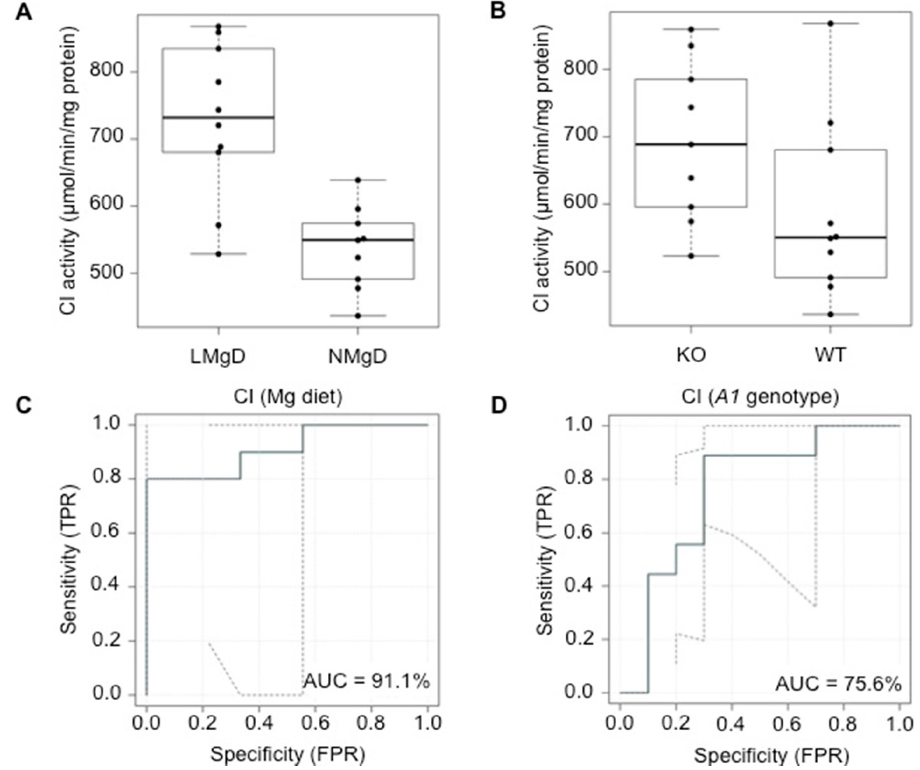
Figure 4. Impact of dietary Mg content and Slc41a1 genotype on the activity of complex I (CI) in murine cardiac mitochondria. ( A ) Box-and-whisker plot overlaid with dot plot showing the influence of dietary Mg content (LMgD vs. NMgD) and ( B ) Slc41a1 genotype ( Slc41a1 − / − vs. Slc41a1 +/+ ) on CI activities in murine mitochondria. For both, A and B, the original source data and corresponding medians are indicated for each group. ( C , D ) Empirical ROC (receiver operating characteristic) curves with the area under the ROC curve (AUC) for ( C ) the type of Mg diet as predictor of CI activity and ( D ) the Slc41a1 genotype as predictor of CI activity. Abbreviations: A1 , Slc41a1 ; FPR, false-positive rate; KO, knock-out; TPR, true-positive rate; WT, wild-type.